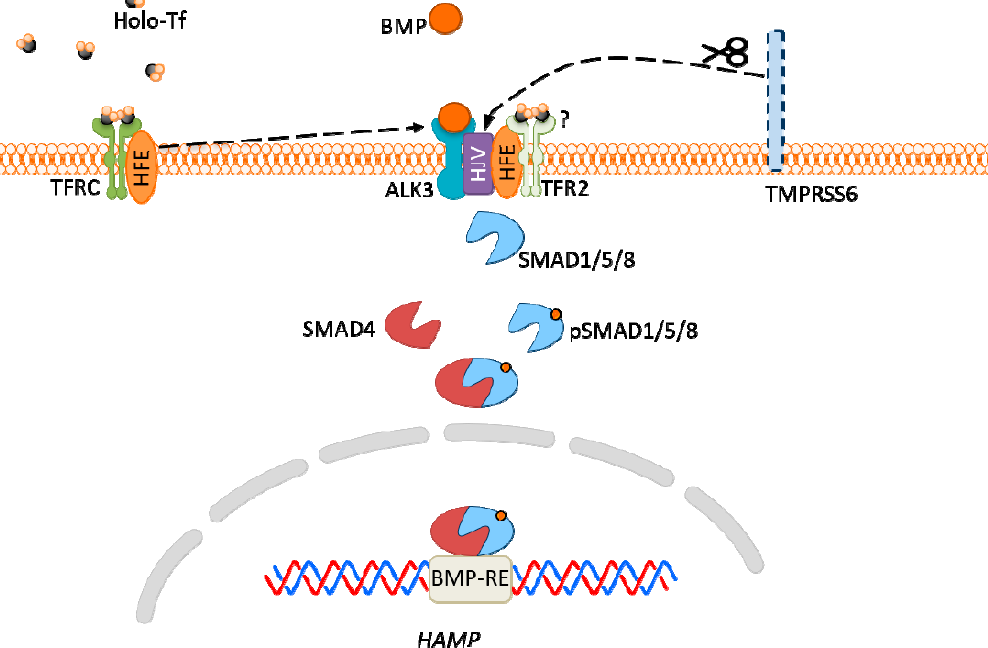
Figure 5. Hepcidin expression via bone morphogenic protein (BMP)-SMAD signaling pathway in hepatocytes. High iron concentration in plasma increases transferrin saturation, which results in homeostatic iron regulator protein (HFE) detachment from the transferrin receptor (TFRC) / HFE complex, then its interaction with ALK3 (BMP receptor), which leads to increased expression of ALK3 and activation of the BMP-SMAD signaling pathway. High plasma iron also causes stabilization of TFR2, which is associated with HFE, and may also interact with ALK3 (but this is not confirmed). Hemojuvelin (HJV) is a co-receptor for BMP, and TMPRSS6 protein cleaves HJV acting as an inhibitor of HJV expression.